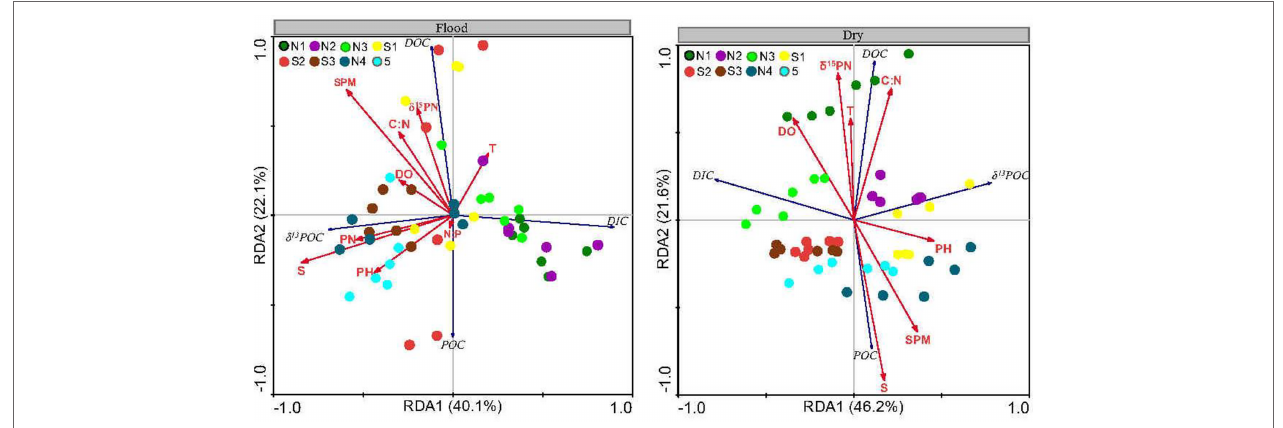
FIGURE 4 | Redundancy analysis ordination showing the relationship between carbon elements and the environmental parameters in the flood and dry seasons (The colors mean different sites).